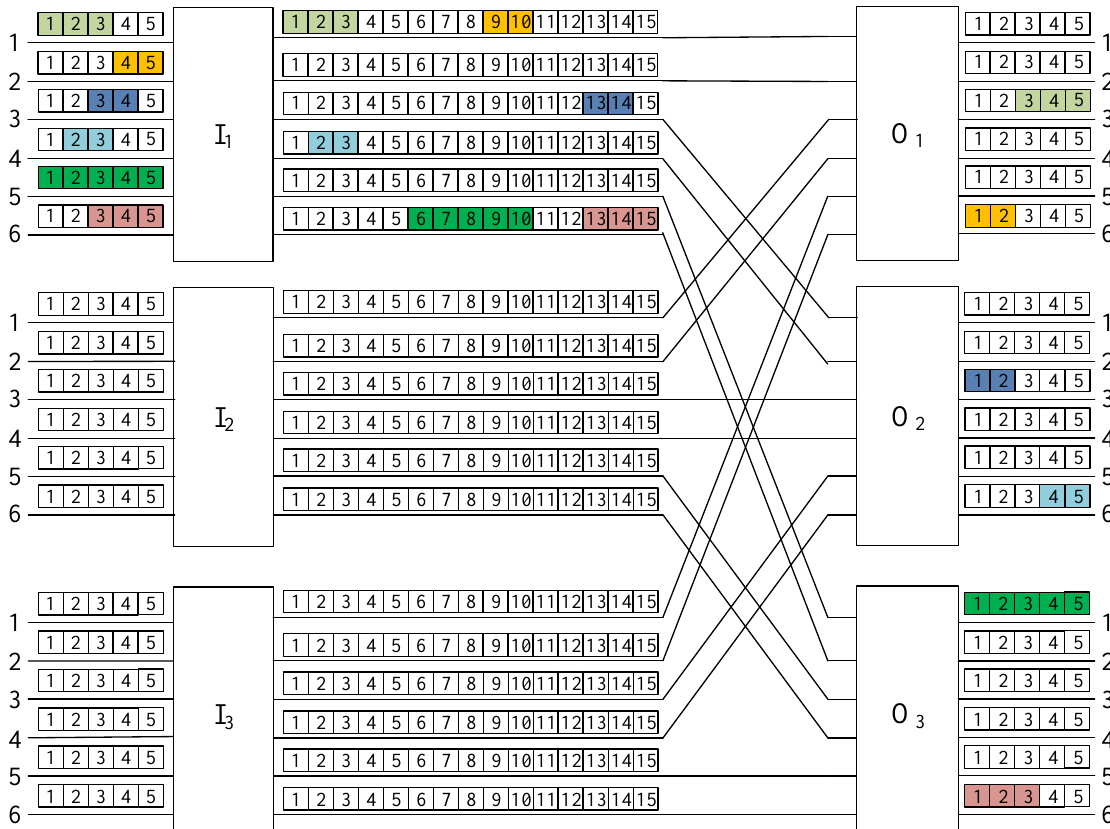
Figure 2. An CC ( 6,3,2,5,15 ) switching